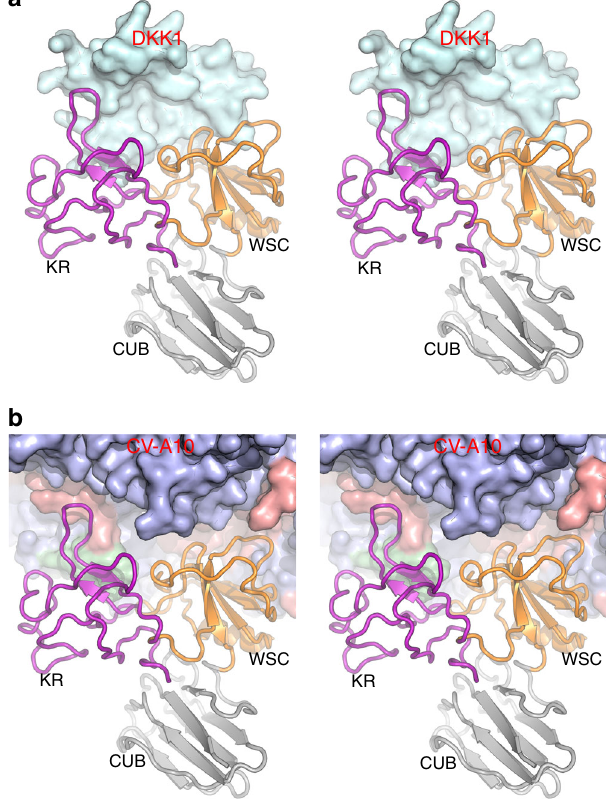
Fig. 2 Stereo diagram showing regions of KRM1 involved in interactions with DKK1 are used in engagement with CV-A10. a Engagement between KRM1 and DKK1. b Engagement of KRM1 to CV-A10. DKK1 and CV-A10 are shown as surface representations with DKK1 in cyan and CV-A10 capsid proteins VP1, VP2 and VP3 in blue, green and red, respectively. KRM1 is drawn as ribbons with KR, WSC and CUB domains coloured in purple, orange and grey,